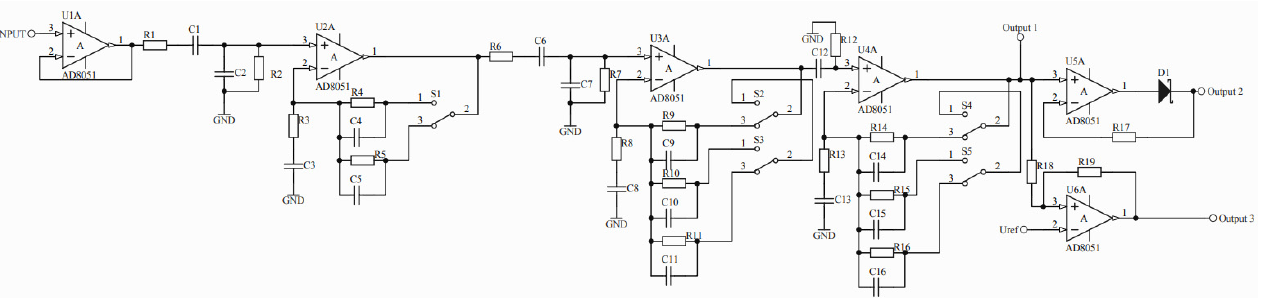
Figure 5. Analog signal processing block diagram.